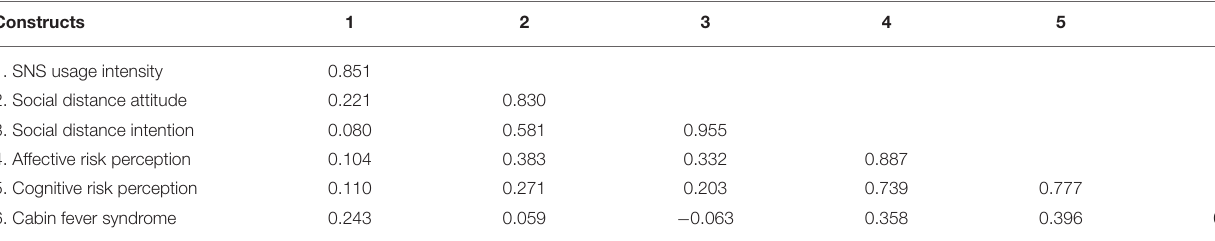
TABLE 3 | Correlation matrix and discriminant assessment. Constructs